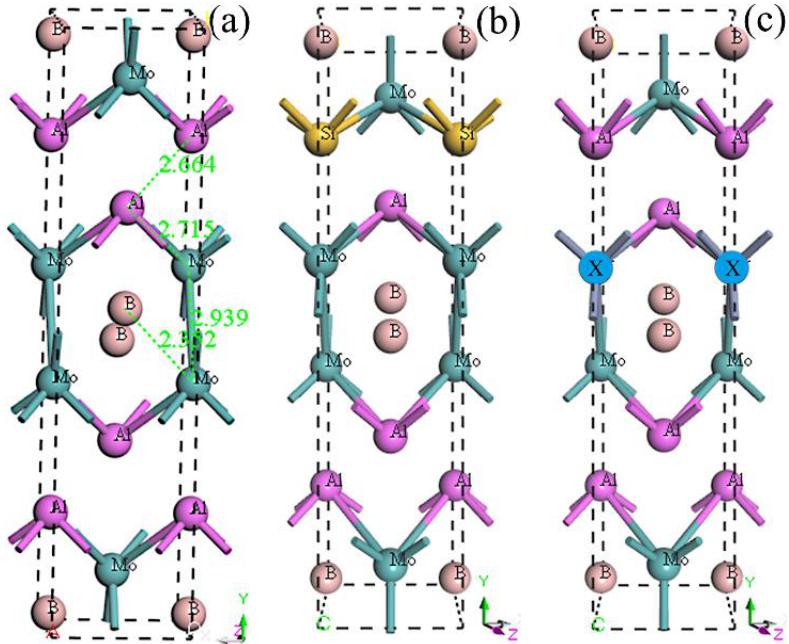
Figure 1. Crystal structures of MoAlB: ( a ) Initial MoAlB (bond distance unit: Å ); ( b ) Si doped MoAlB; ( c ) X doped MoAlB.